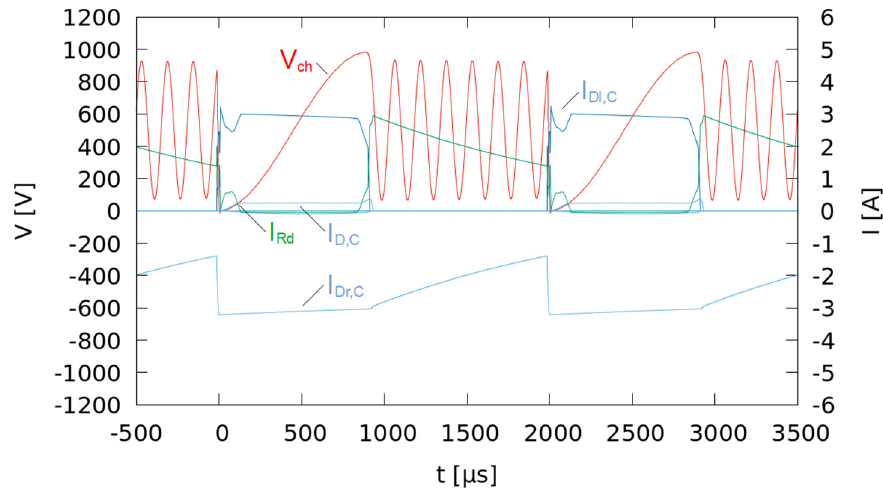
Figure 21. Common-mode current components through the diodes are shown in light-blue colour.